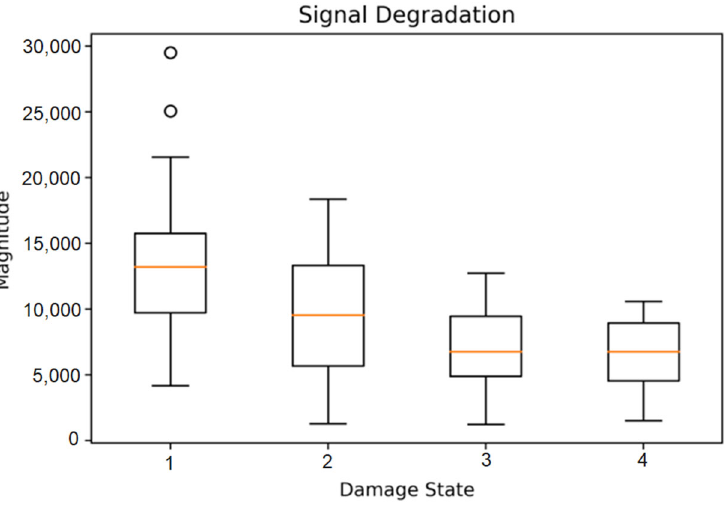
Figure 3. The figure consists of four box plots, one of each damage state (damage size of 500 µ m). The individual box plot computes the variation in the second maxima amplitude value of PSD plots. As explained in Section 4.2, the plot approximately represents the power stored by those signals.